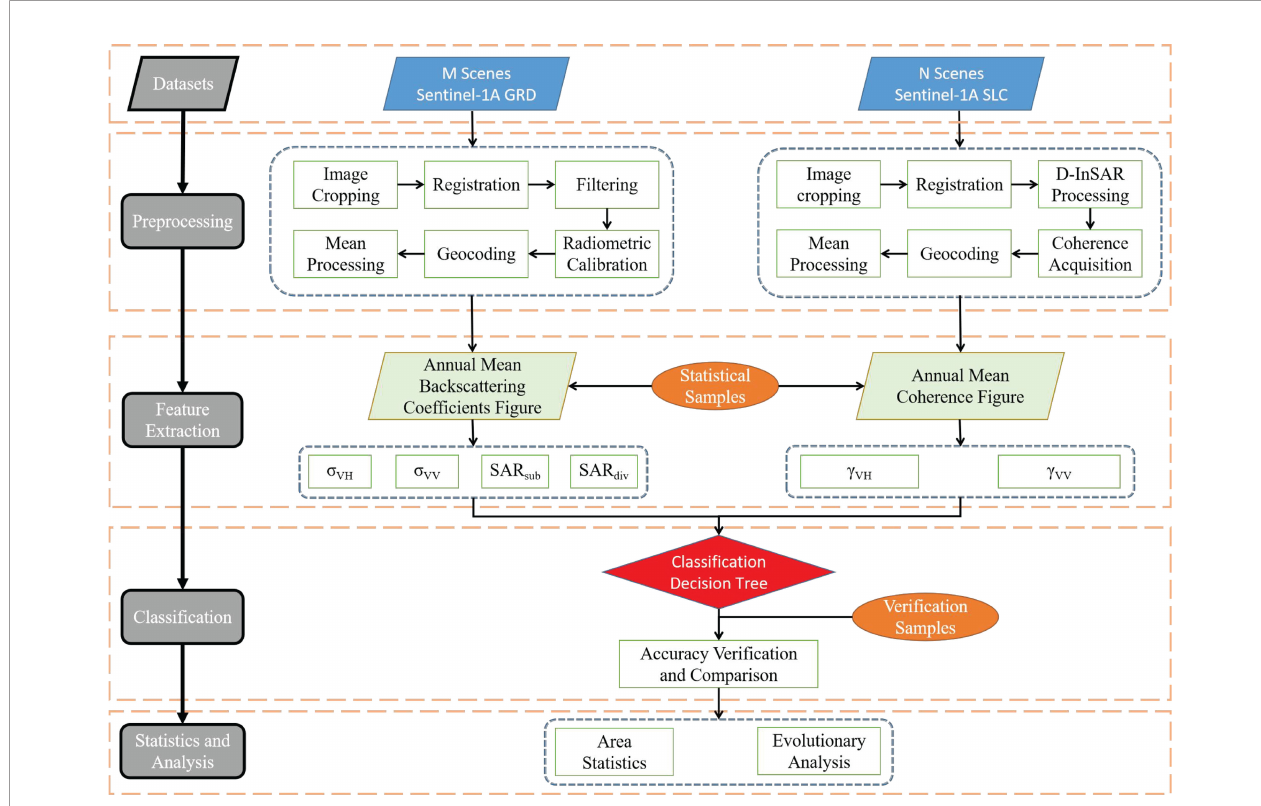
FIGURE 2 | Overall technical fl ow chart used for monitoring the wetland in the Yellow River